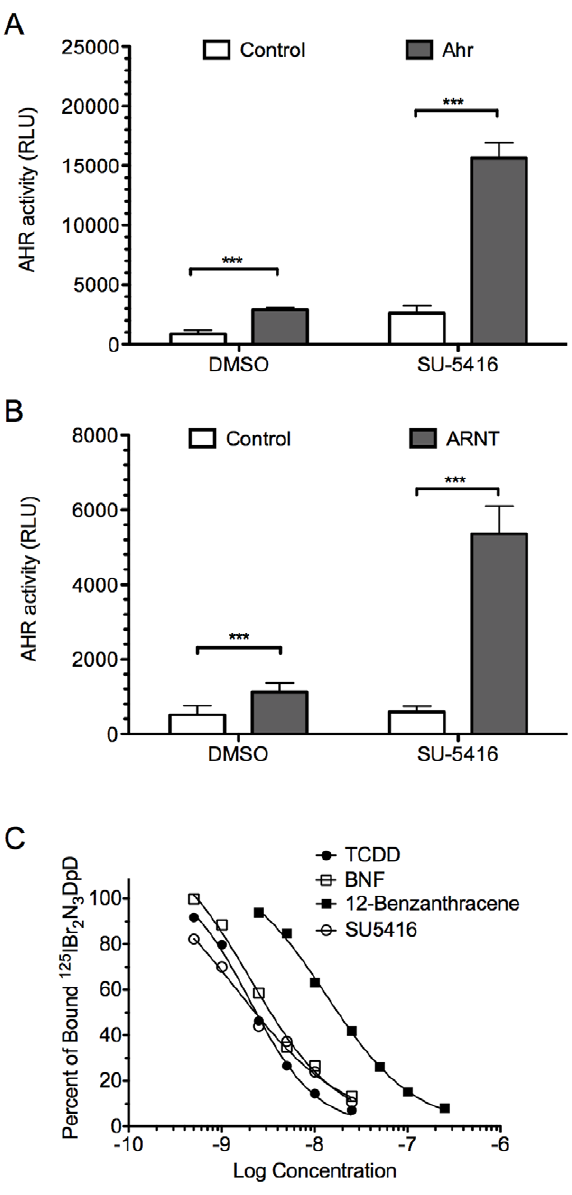
Figure 2. Induction of DRE-mediated transcription by SU5416 is AHR dependent. A. The AHR-mutant C35 cell line was transfected with the AHR b , lacZ gene and a 3 6 DRE-Luc construct. Controls were transfected with the empty pSPORT vector plus the reporter constructs. After 24 h, the cells were treated with 3 m M SU5416 or 0.3% (v/v) DMSO, then incubated for 18 more h. Induction of AHR activity was determined by normalizing the luciferase activity to b -galactosidase activity. White bars : Empty vector. Grey bars : AHR. Error bars : SD; (n=3). B . Induction of DRE-mediated transcription by SU5416 is ARNT dependent. The ARNT-deficient C4 cell line was transfected with the human ARNT or the pSPORT parent vector. These cells were also co- transfected, treated and assayed as in A. White bars : Empty vector. Grey Bars : ARNT. Error bars : SD; (n=3). C. SU5416 is a ligand of the AHR. The hepatic cytosolic fraction from C57BL/6J mice was incubated with 1 nM of the radioligand 125 BR 2 N 3 DpD, in the presence of increasing concentrations of competitor, SU5416, TCDD, BNF or 1,2-Benzanthra- cene. Ordinate: Specifically bound radioligand in the presence of competitor divided by specifically bound radioligand in the absence of competitor. Abscissa: The concentration of competing ligand, repre- sented as log of molar concentration. Each data point represents the average of two determinations. Competitive binding to the